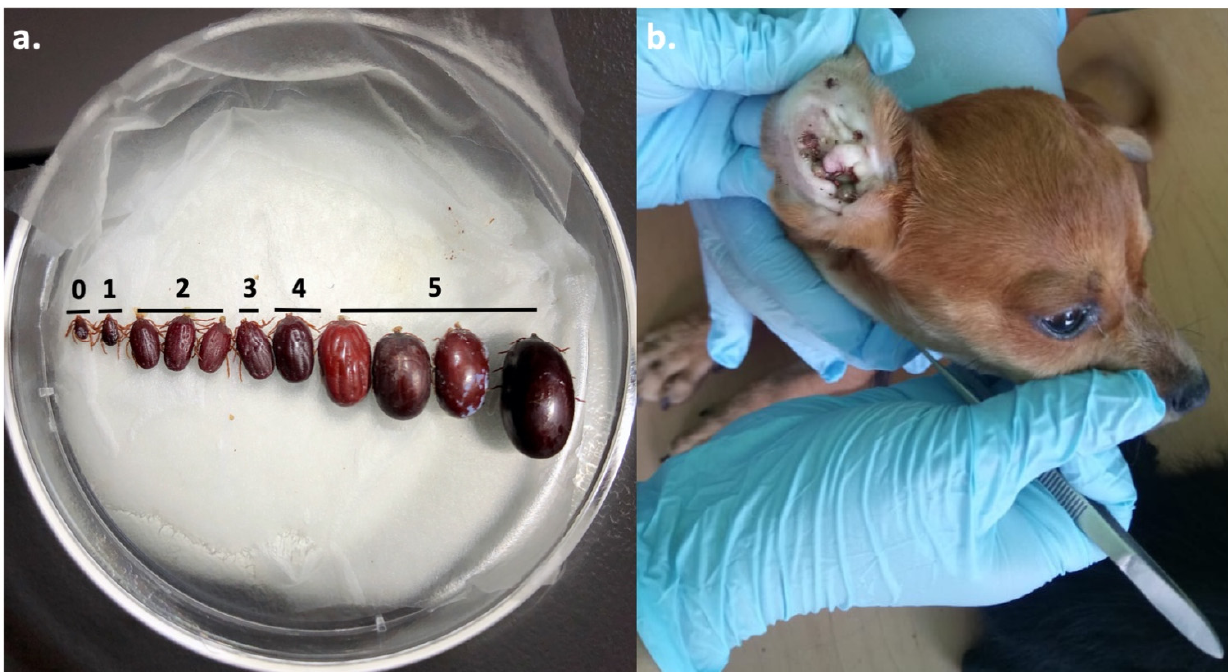
Figure 2. ( a ) Ticks were scored for engorgement on a scale from 0 to 5. This image is an example of the scoring scale for Rh. sanguineus s. l. adult females. Each life stage was scaled appropriately, except males were grossly indistinguishable and were therefore not scored for engorgement. ( b ) Removing ticks from participating dog ears upon inspection. This individual Chihuahua had 526 Rh. sanguineus s. l.